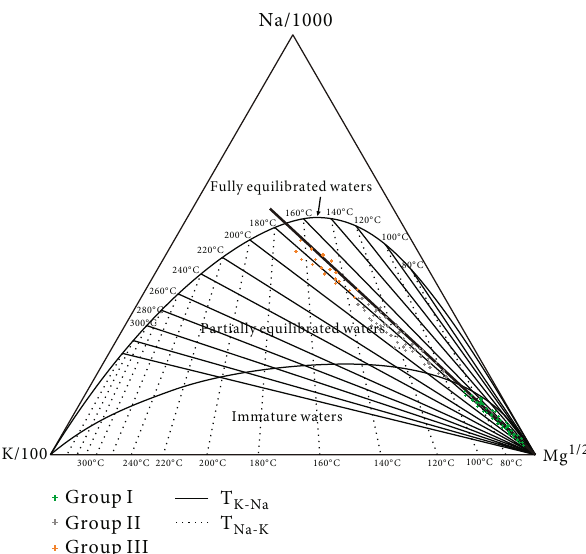
Figure 9: Na-K-Mg triangle diagram of the geothermal water in the buried hill of the study